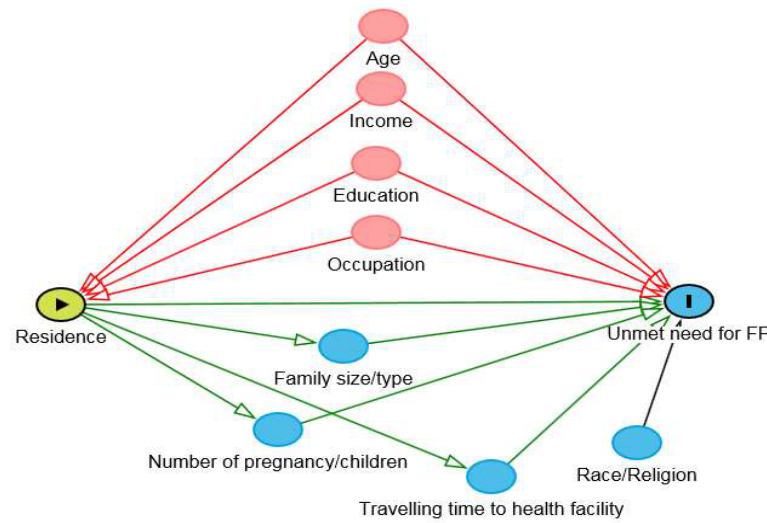
Figure 3. Directed acyclic graph (DAG) on the association between urban-rural residence and unmet need for family planning among 18–49-year-old married women in south and north Yangon.